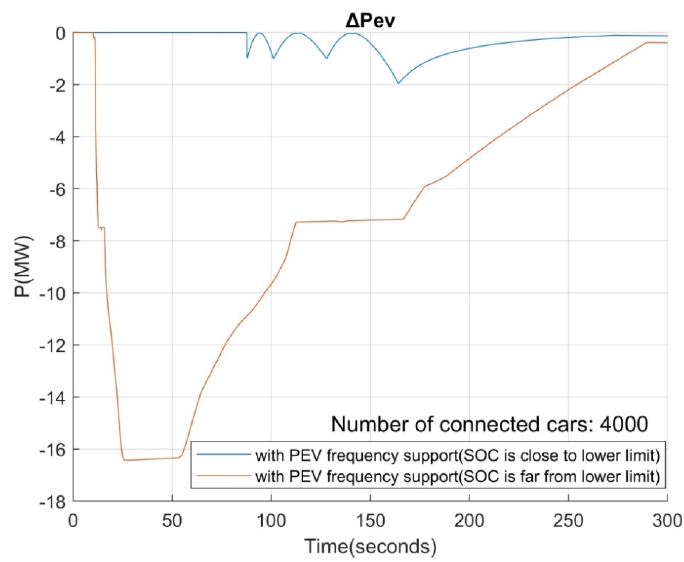
Figure 14. Total power generation from a certain number of PEVs depending on SOC level.